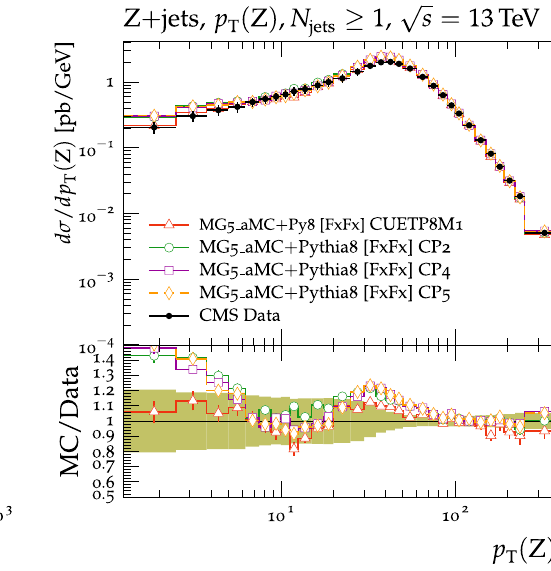
shown, where the shaded band indicates the total experimental uncer- tainty in data. Vertical lines drawn on the data points refer to the total uncertainty in the data. Vertical lines drawn on the MC points refer to the statistical uncertainty in the predictions. Horizontal bars indicate the associated bin